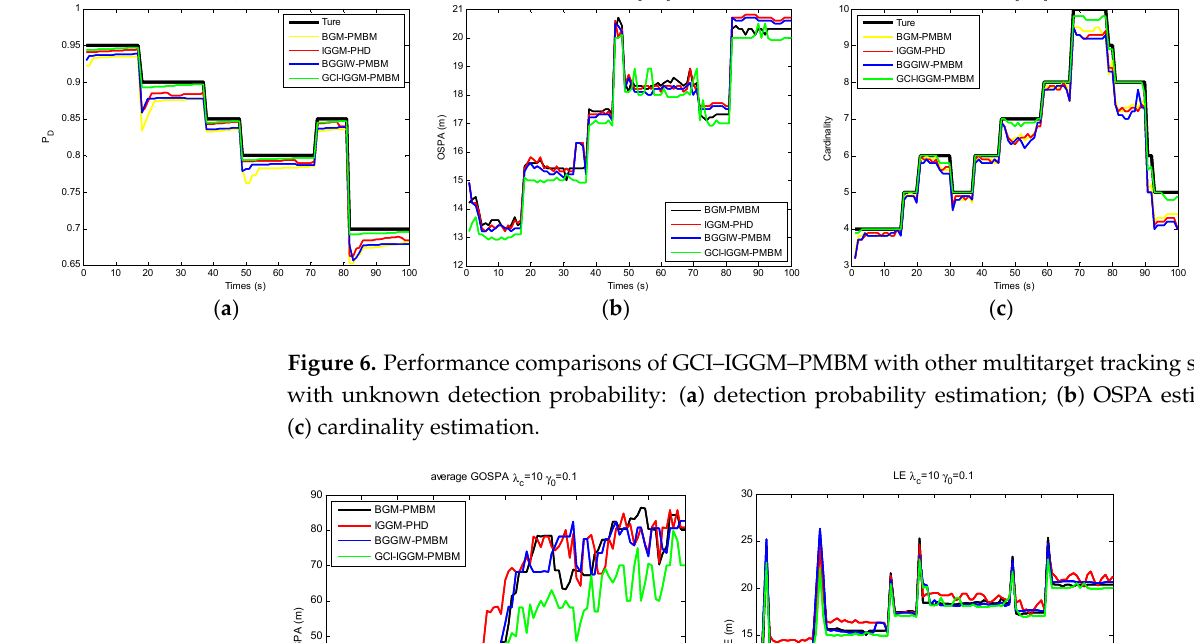
Figure 5. Cardinality comparisons of GCI–IGGM–PMBM (our proposed scheme) with other multitarget tracking schemes: ( a )